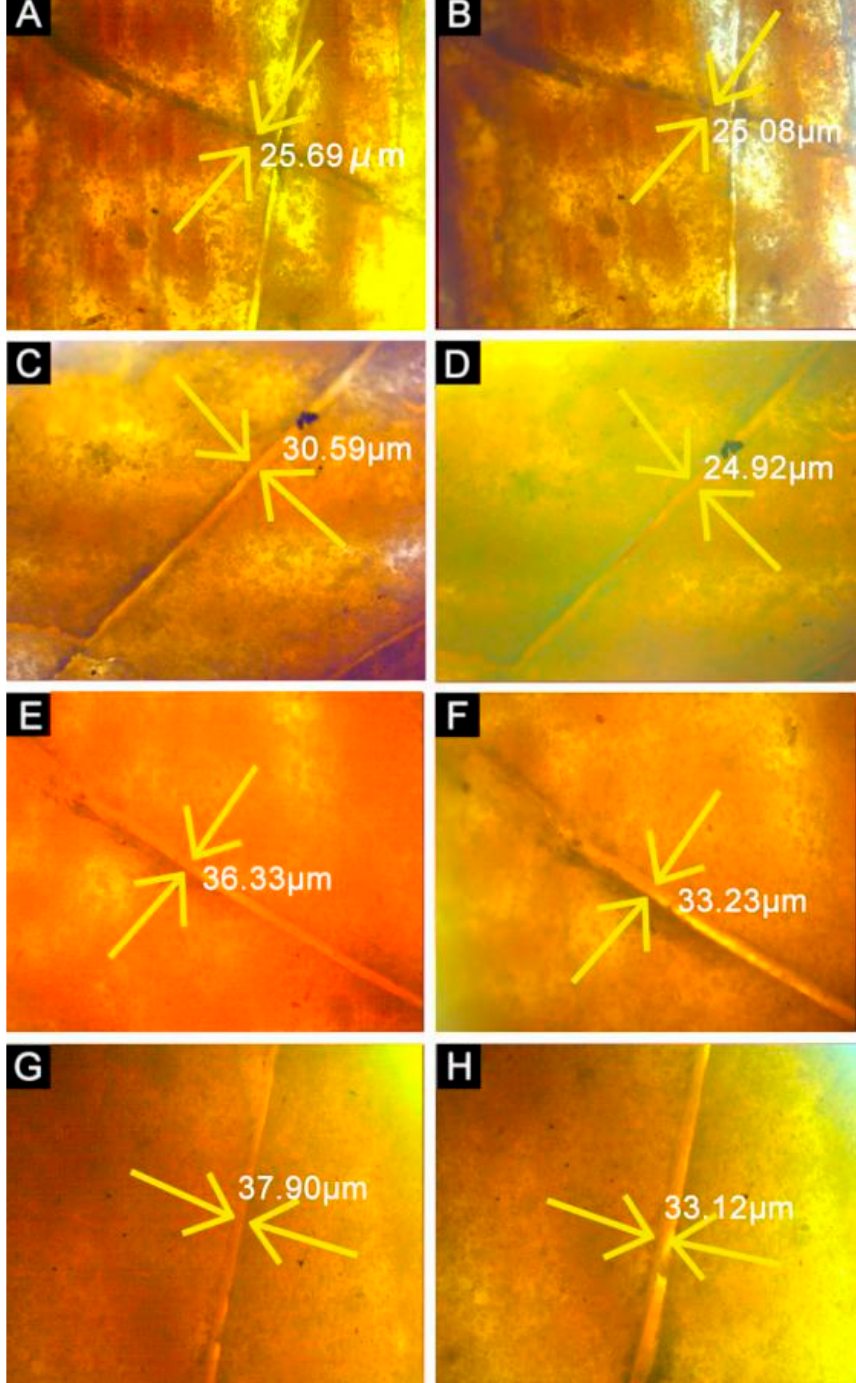
Figure 2. Coating scratch OM: ( A,B ) repair before and after PS0TD20; ( C , D ) repair before and after PS5TD20; ( E , F ) repair before and after PS15TD20; ( G , H ) repair before and after PS25TD20.